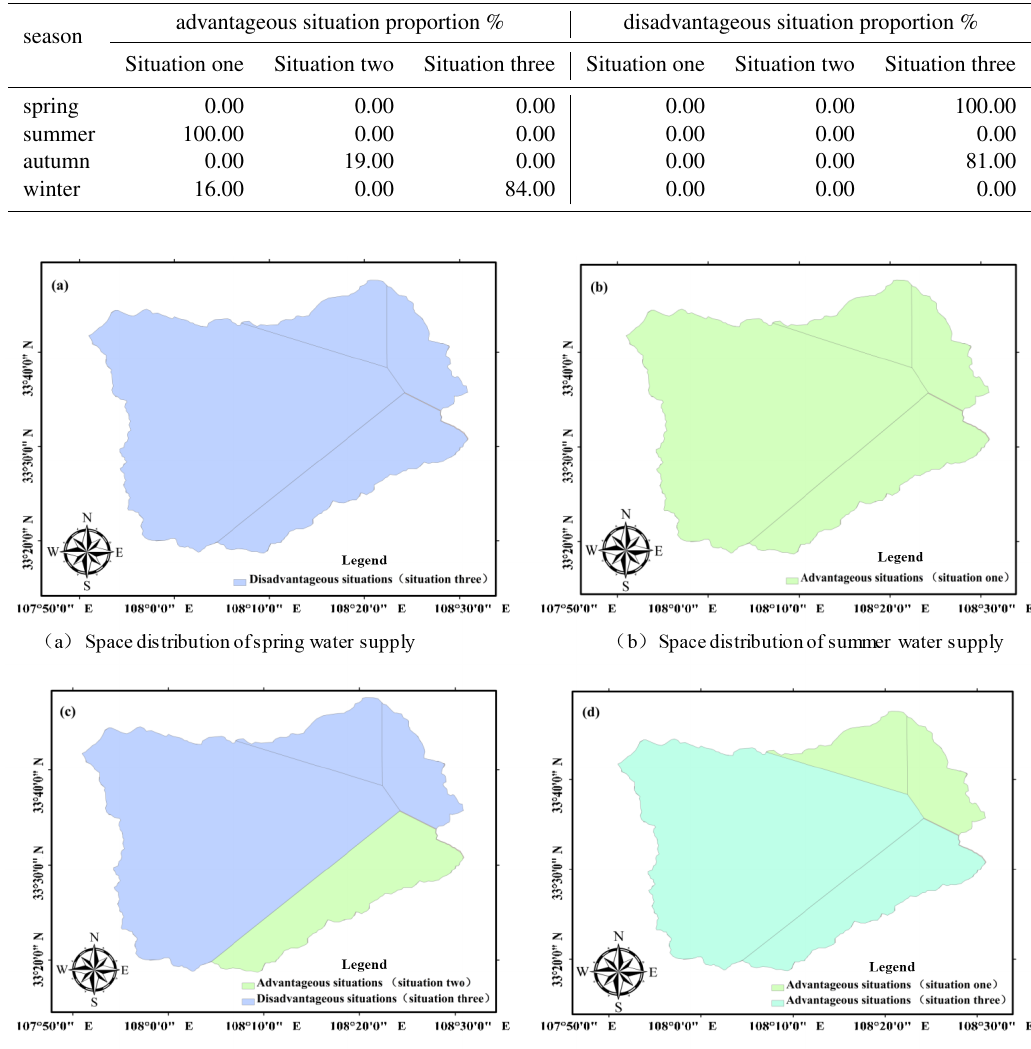
Figure 4. Spatial distribution of future water supply in the